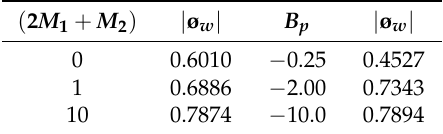
Table 2. The effect of the normal stresses ( 2 M 1 + M 2 ) and B p on the wall shear stress. ( 2 M 1 + M 2